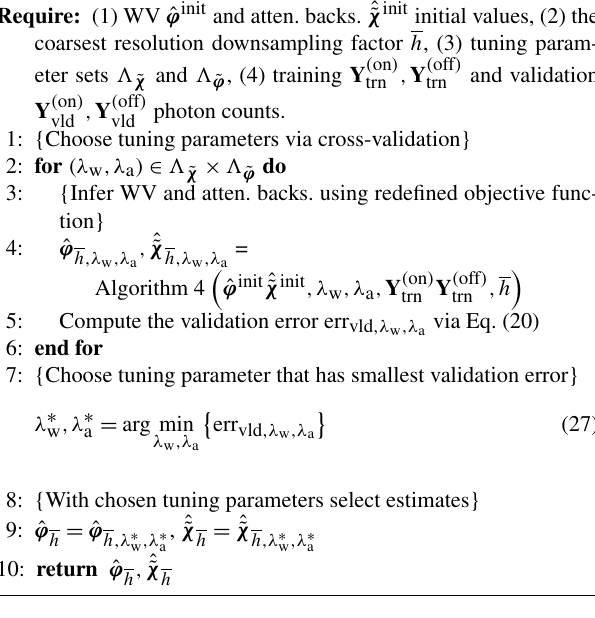
Table 3. The first column indicates the lidar instrument and where the instrument was located. SGP refers to the Southern Great Plains in Oklahoma, and Marshall refers to Marshall field in Boulder, Col- orado. The second and third column show the corresponding laser power and telescope diameter.